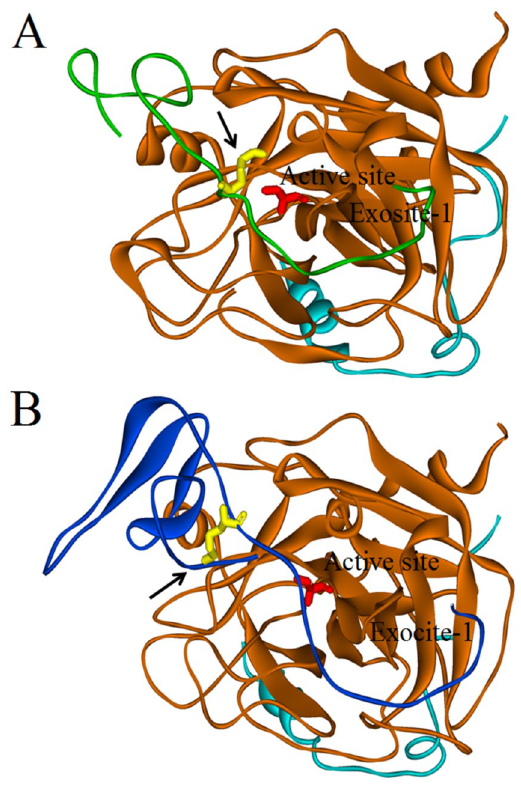
Figure 7. Cartoon (Solid ribbon) representation of comparative structure of sculptin (single domain) and crystal structure of hirudin bound to thrombin. The brown and cyan color represent the heavy and light chains of thrombin respectively. ( A ) Sculptin in green bound to thrombin. ( B ) Hirudin in blue bound to thrombin. Lys residue of the inhibitors is shown in yellow and Ser 195 residue of the thrombin active site is presented in red. The arrow indicates the active site binding pocket of the thrombin occupied by Lys 23 residue of sculptin ( B ) and by the N-terminal region of hirudin ( A